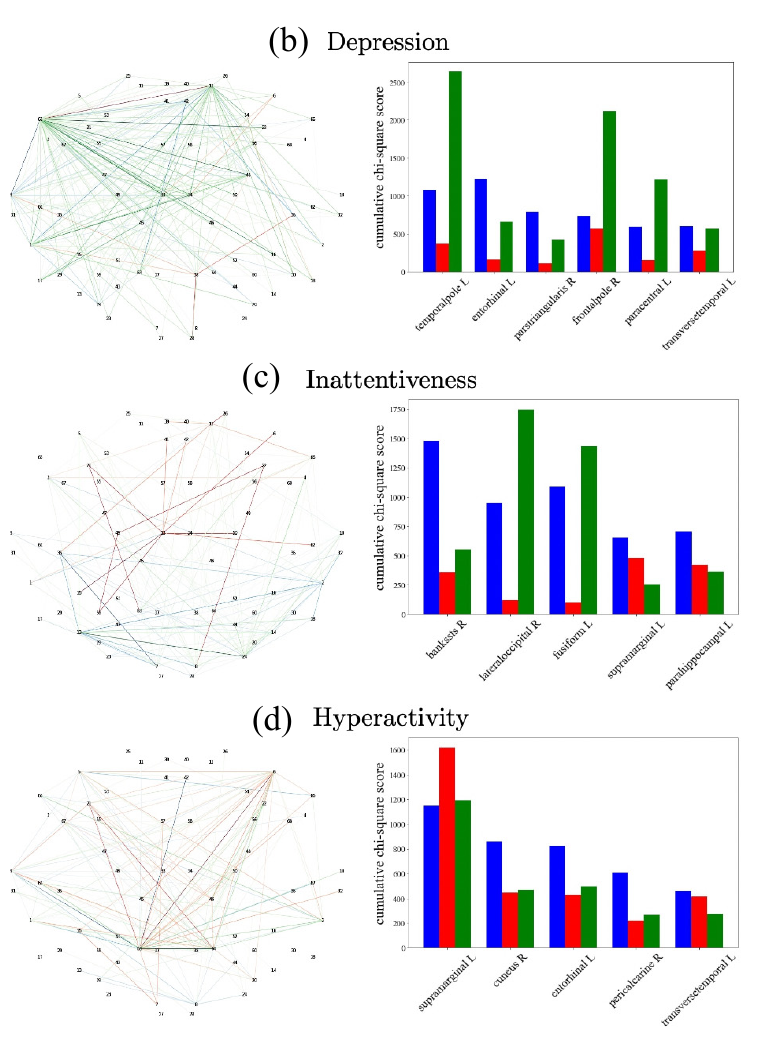
Figure 6. Frequency bands with highest cumulative chi-square scores across ROIs. ( left ) Topographical plot of ROIs whose edges are colored to represent the frequency band with the largest cumulative chi-square score. ( right ) The cumulative chi-square value of each frequency band in the top 5 ROIs.